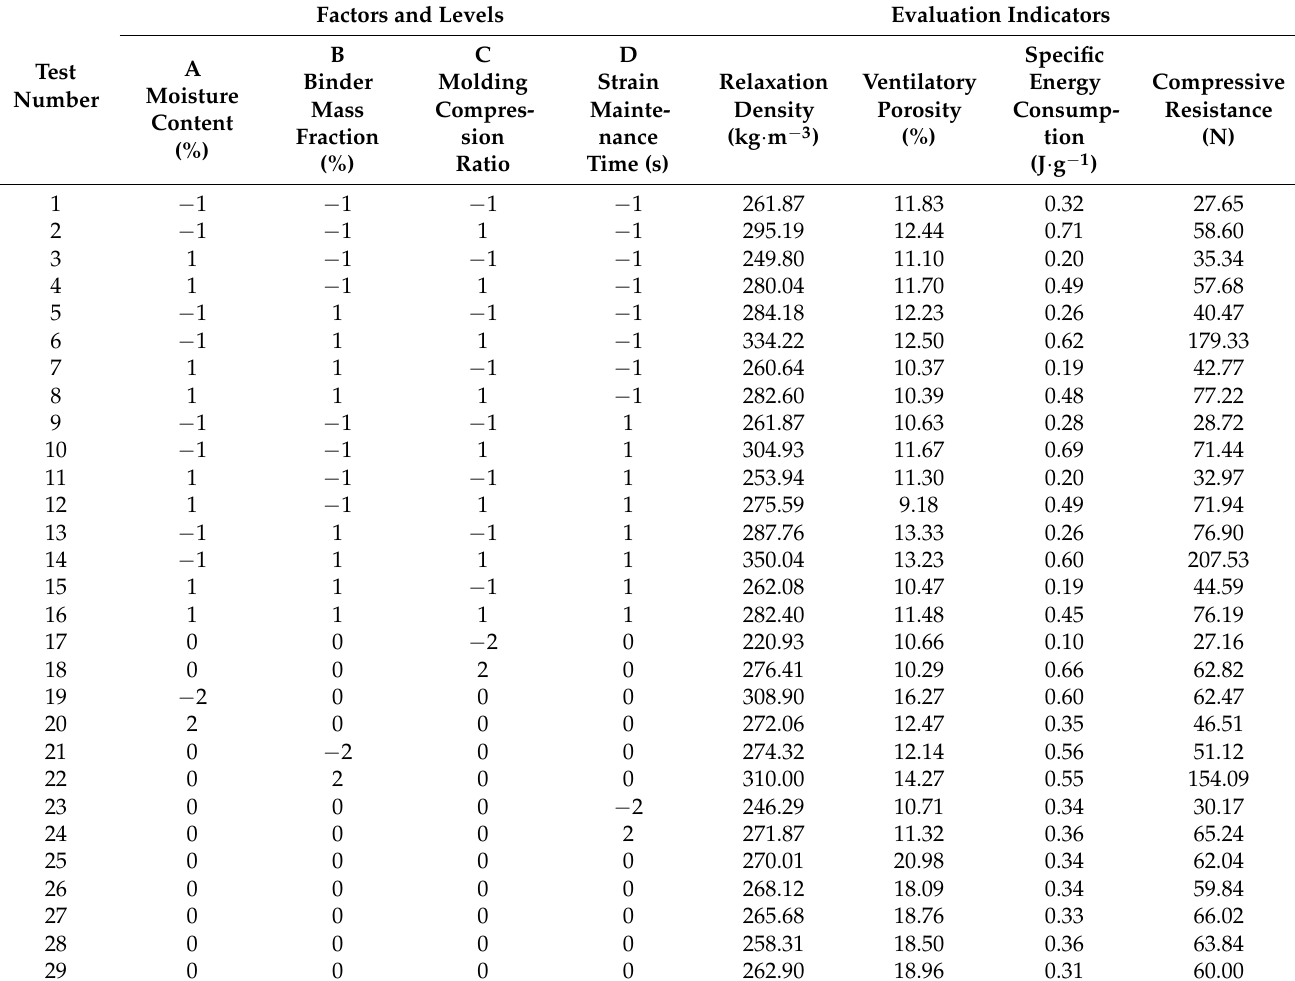
Table 3. Test scheme and